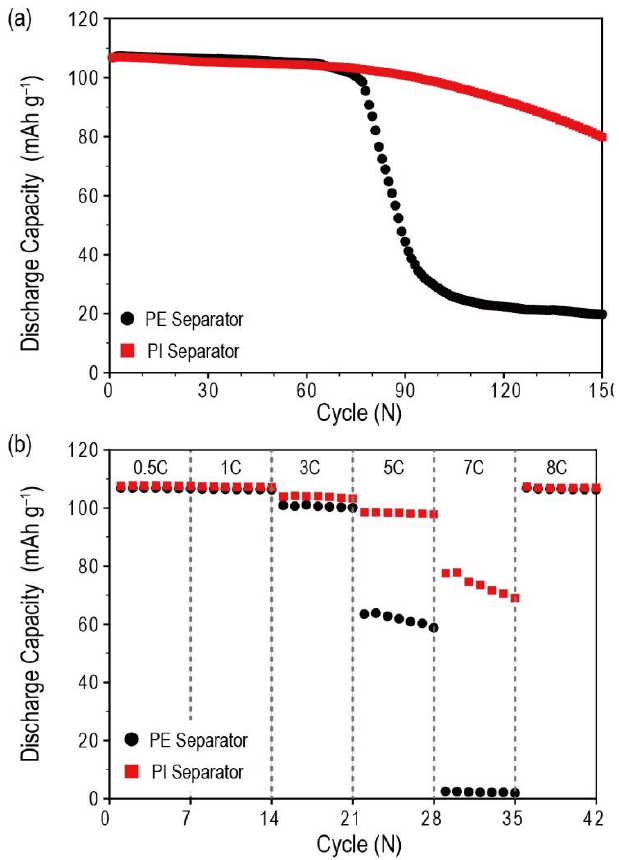
Figure 8. Electrochemical performance including ( a ) cycle performance (charging and discharge current density = 1C (1.2 mA cm − 2 )) and ( b ) rate capability (charging current density = C / 2 (0.6 mA cm − 2 ), discharging current densities varied from C / 2 (0.6 mA cm − 2 ) to 7C (8.4 mA cm − 2 )) of Li half cells containing different types of separators (bare PE and porous PI separators).